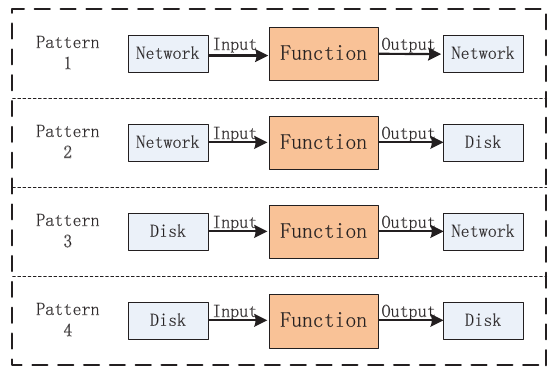
Fig. 3. Data process patterns in